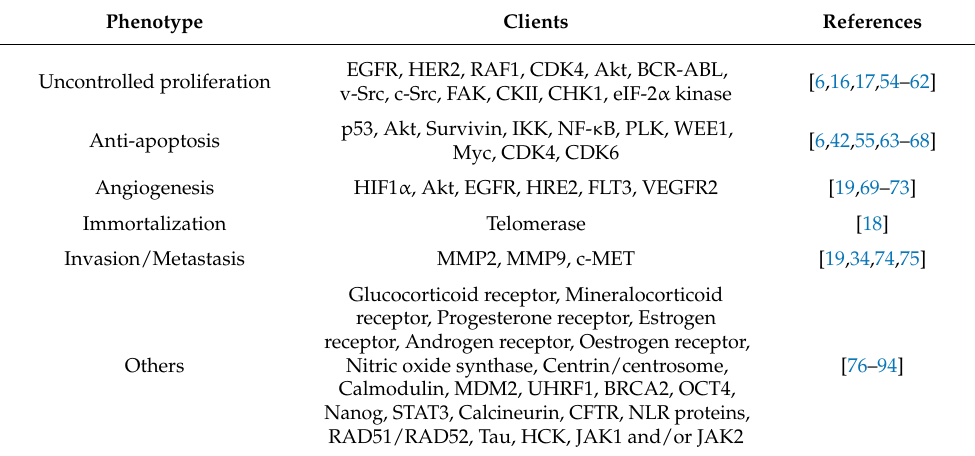
Table 1. HSP90 clients are associated with hallmarks of